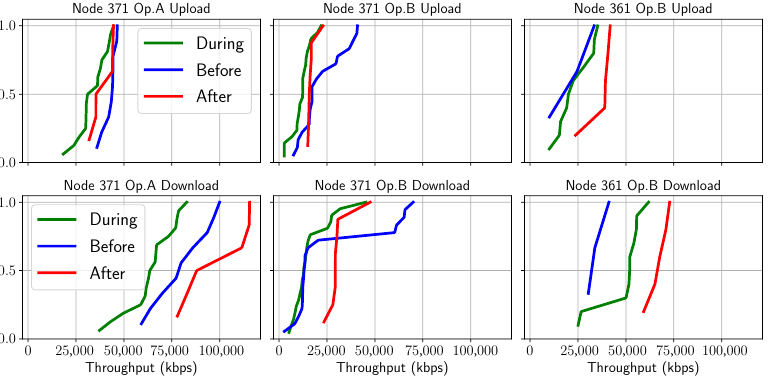
Figure 5. CDF of NetTest throughput behavior before/during/after the match; the upper row corresponds to uploading and lower to